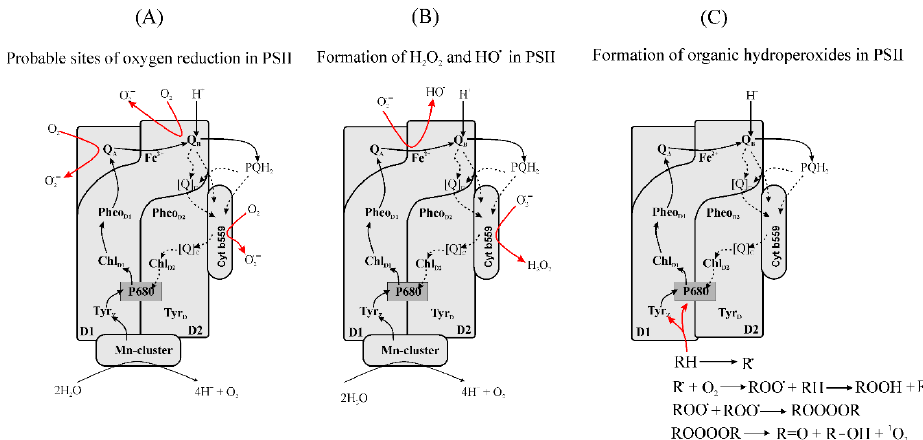
Figure 2. Formation of reactive oxygen species (ROS) in PSII. ( A ) Formation of superoxide (O 2• − ) can occur with the interaction of O 2 with a semiquinone anion radicals at the Q A and Q B sites, when the electron flow from Q B to the PQ pool is limited. The low potential form of cyt b559 can reduce O 2 to